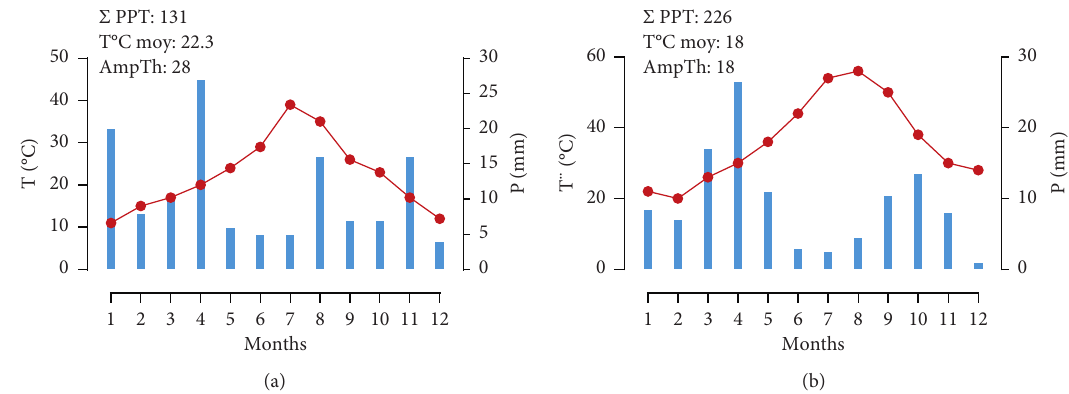
Figure 1: Monthly weather data from the experimental station of the Faculty of Science in Oujda, for the experimental period January- December 2016 (a) and January-December 2017 (b). Σ PPT: sum of precipitation, AmpTh: temperature range, T ° C moy: mean temperature. Table 1: Effect of different shade treatments (control, 30%, 50%, and 70%) on the harvest period, number of flowers, weight, and length of stigmas. The values are the averages of 3 replicates. Flowering duration (day) Shade treatments